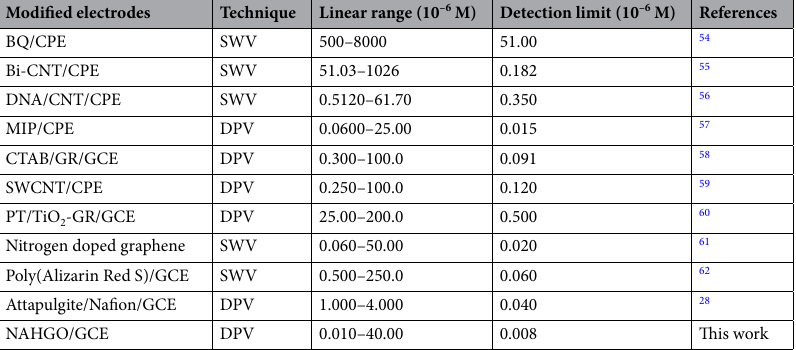
Table 1. An overview of electrochemical methods for the determination of caffeine.